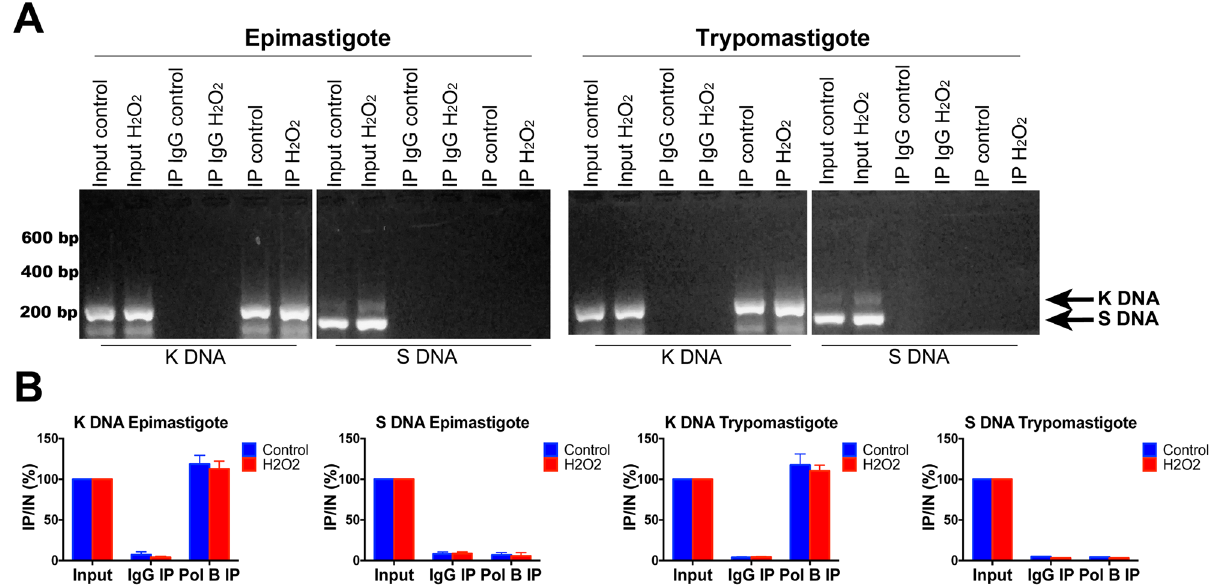
Fig 1. Crosslinking of Tc DNA polymerase β to kinetoplastid DNA. (A) T . cruzi epimastigote and trypomastigote forms were treated with peroxide. Proteins were crosslinked to the DNA with formaldehyde and then DNA was sheared and immunoprecipitated with antibodies against Tc DNA polymerase β ( α DNA β -Pol) or control IgG. Revert-crosslinked DNA precipitated (IP) was purified and amplified by PCR to amplify nuclear satellite DNA (S DNA) or kinetoplastid DNA (K DNA). (B) Quantification of PCRs amplifying S DNA and K DNA are indicated above the gel panel. Results are indicated as the mean +/- SD of three independent experiments. Input (IN) corresponded to 2% of total starting DNA and precipitated DNA (IP) represents 50%. (cid:3) indicates p < 0.05.